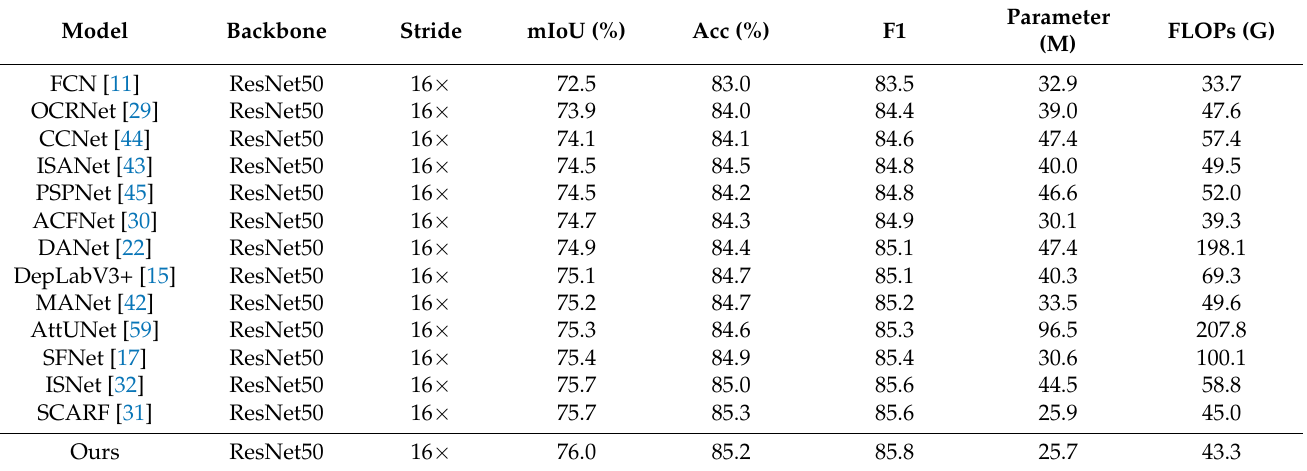
Table 5. Quantitative comparisons with state-of-the-arts on Potsdam test